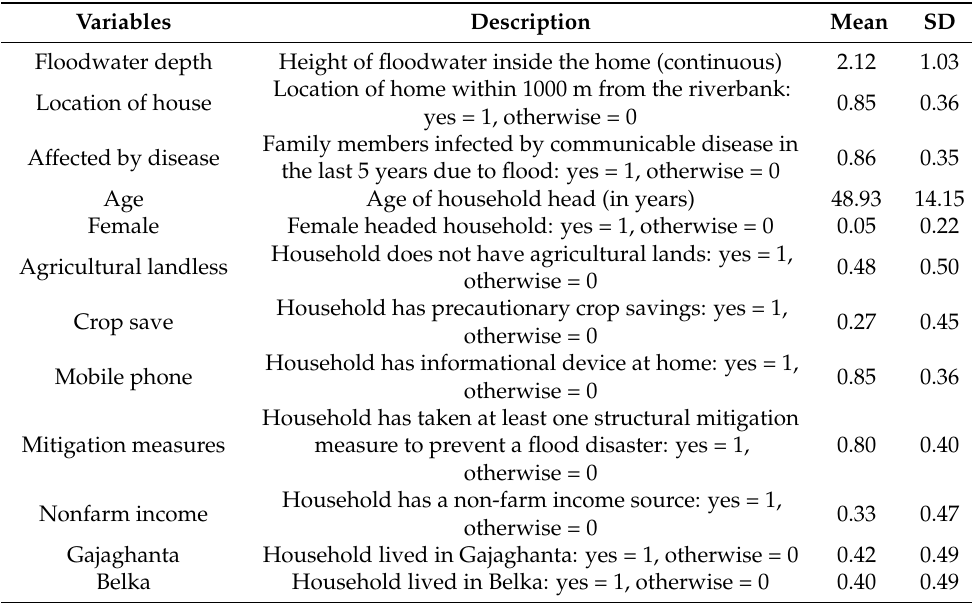
Table 2. List ofvariables used in this study (Source: Field Survey,